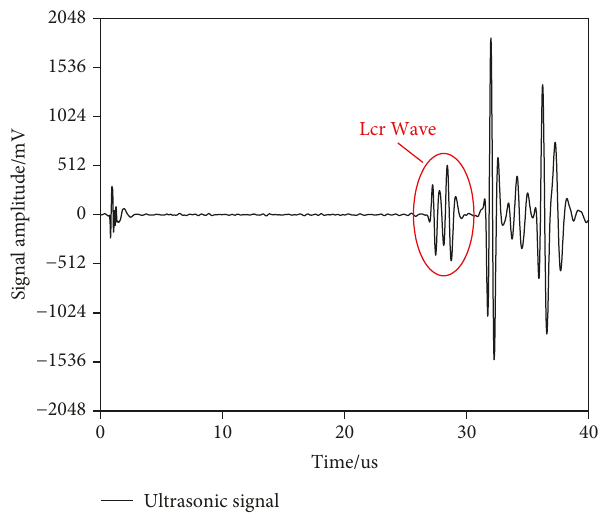
original sampling data . . fourier interpolation by 10 times Figure 9: Ultrasonic signals before and after interpolation in di ff erent stress states.